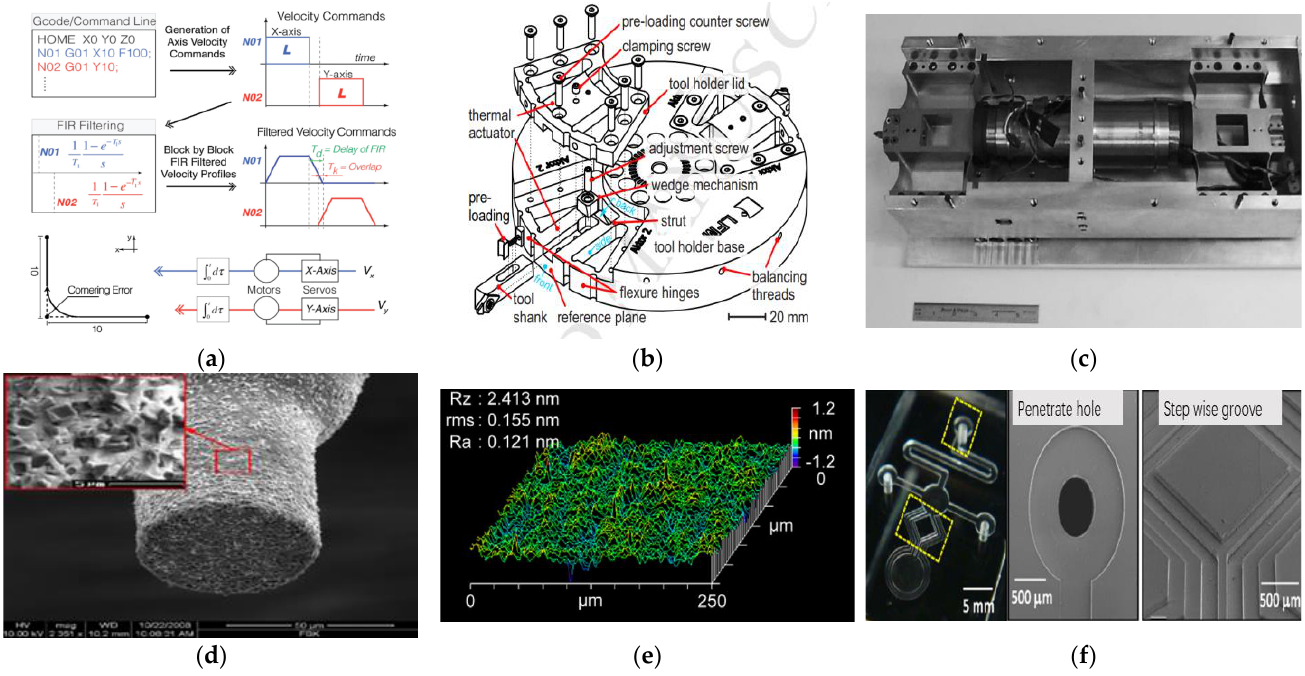
Figure 2. ( a ) Corner smoothing scheme. Reprinted with permission from ref. [31] Copyright 2015 Elsevier; ( b ) Adjustable handle design [32]; ( c ) FTS and mass dampers [33]; ( d ) SEM image of grind- ing prop. Reprinted with permission from ref. [34] Copyright 2009 Elsevier; ( e ) Surface roughness